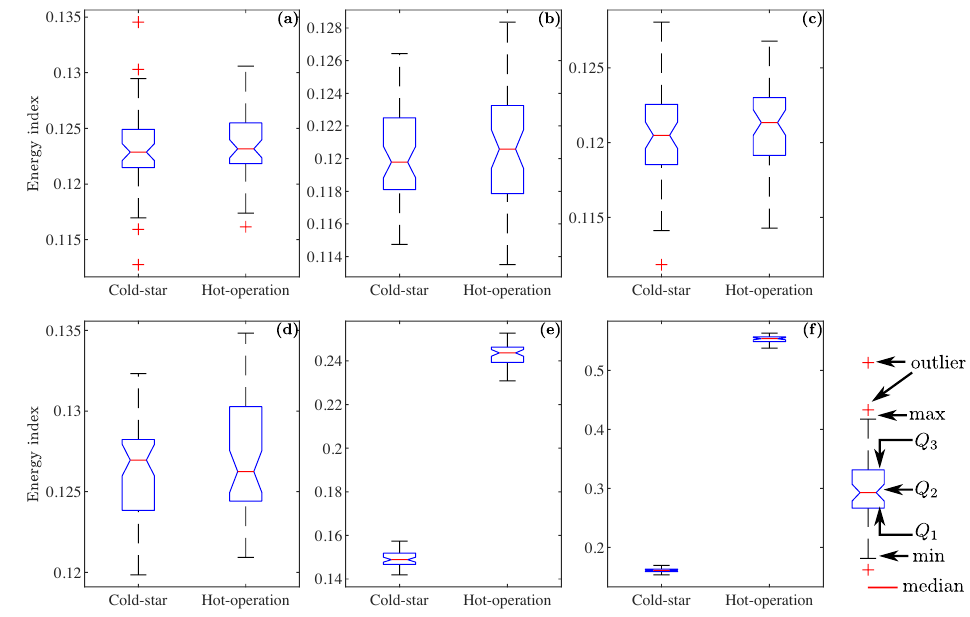
Figure 9. The energy index values from the “cold-start” and “hot-operation” datasets, corresponding to a noise level of 5 dB for level 1 detail: ( a – c ) set of values for joints 1 to 3; ( d – f ) set of values for joints 4 to